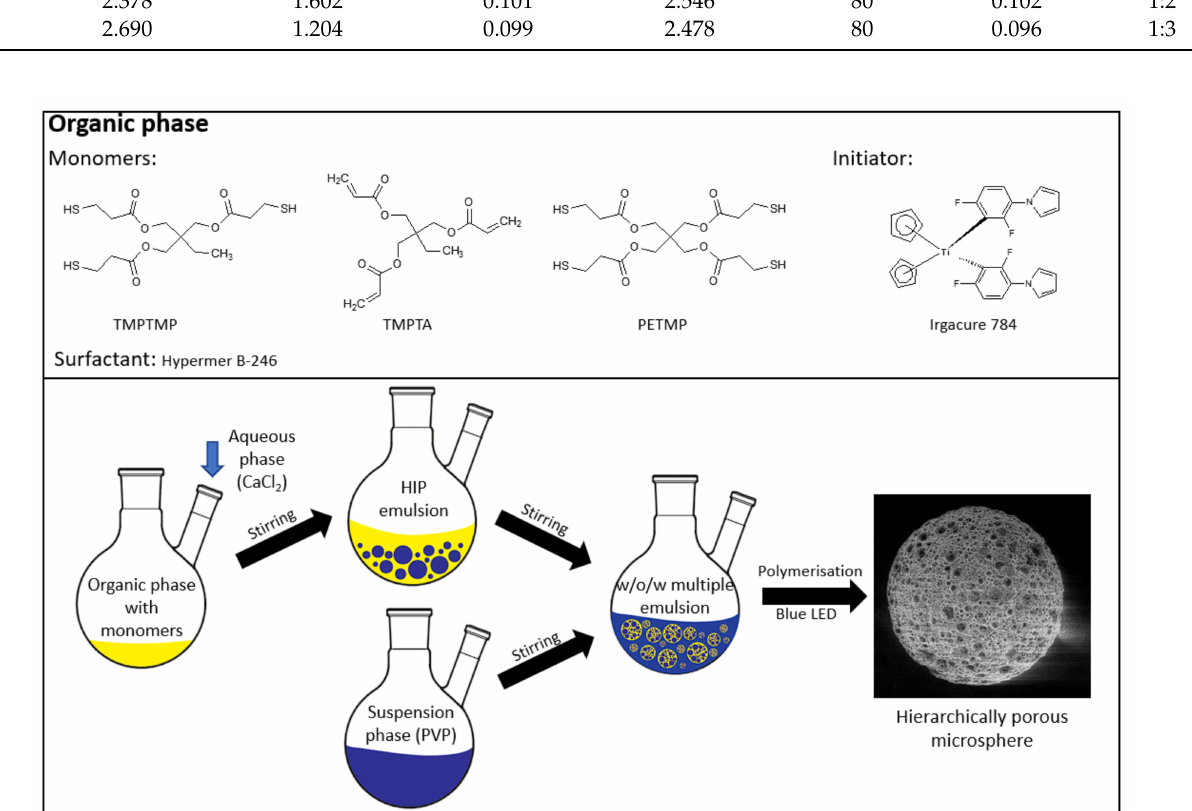
Figure 1. Microsphere